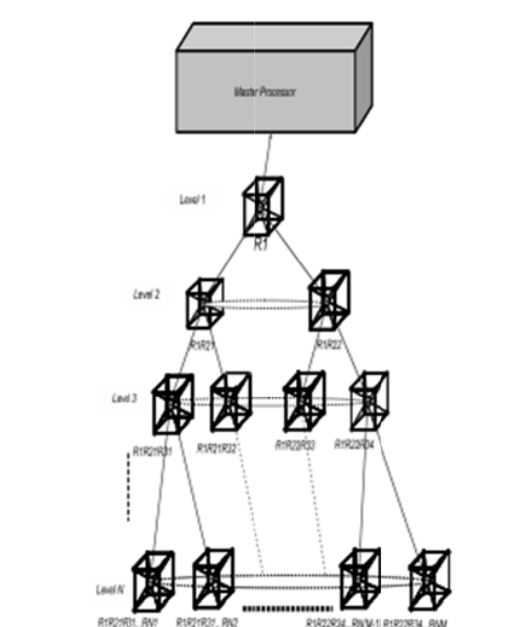
Figure 5: M Architecture processor to final